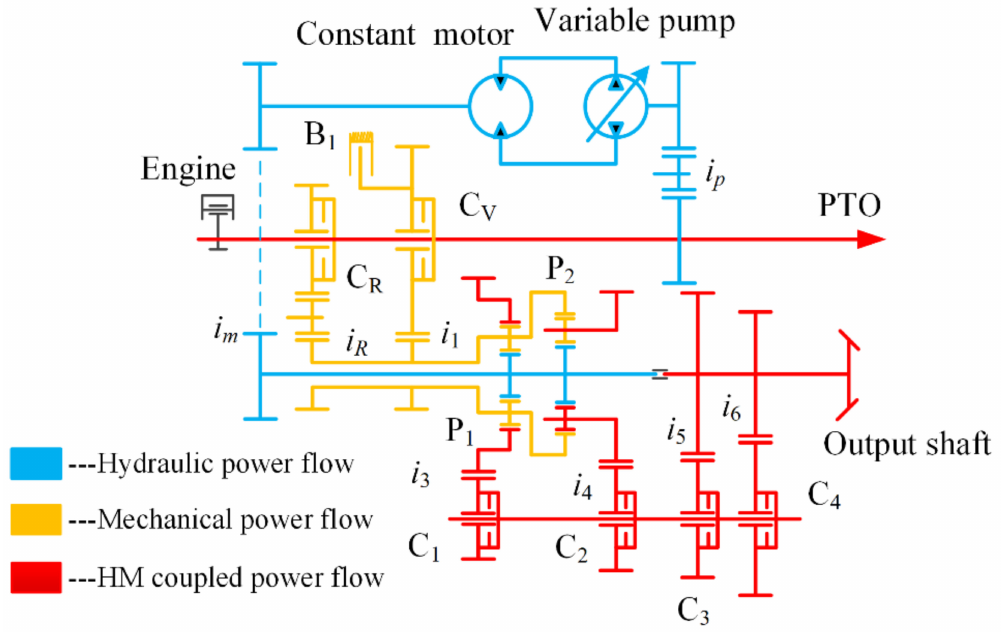
Figure 1. Transmission scheme of a novel 5-stage hydro-mechanical continuously variable transmis- sion (HMCVT).